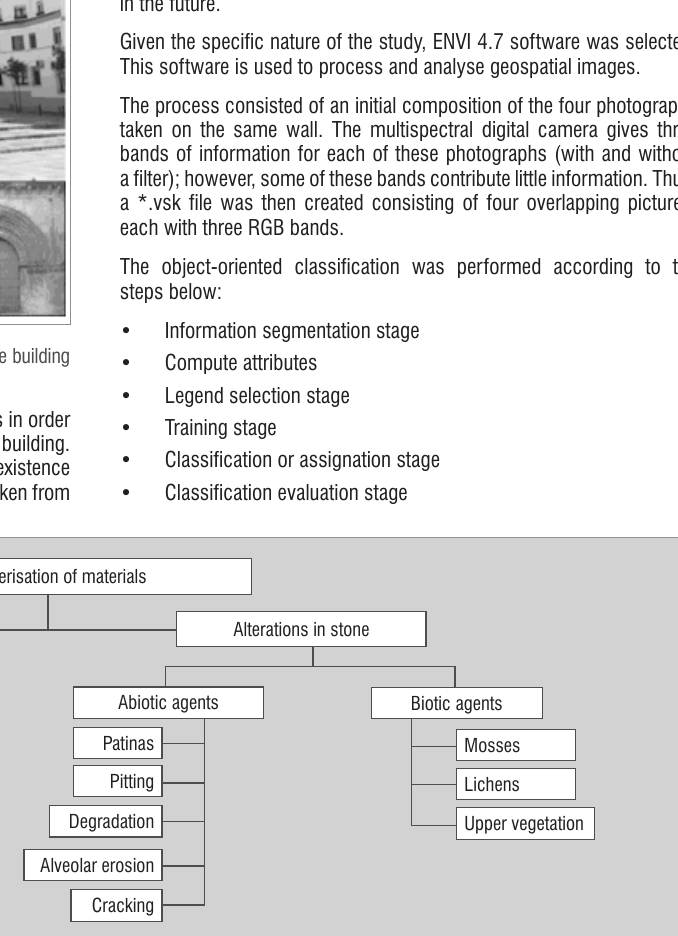
Figure 3: Characterisation of materials on the church